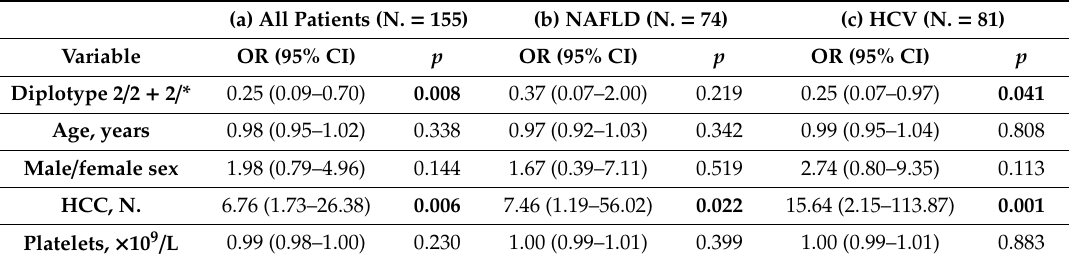
Table 9. Predictive parameters of high plasma periostin (i.e., last quintile) values. Both odds ratios (OR) with the corresponding 95% confidence intervals (CI) and statistical significance ( p values) are reported of a maximum-likelihood logit regression model with high (i.e., belonging to the last quintile) plasma periostin as dependent variable, and POSTN diplotype (categorized as 2 / 2 plus 2 / * versus * / *), age, sex, HCC, and platelet count as predictor variables. (a): all patients. (b): NAFLD patients. (c): HCV